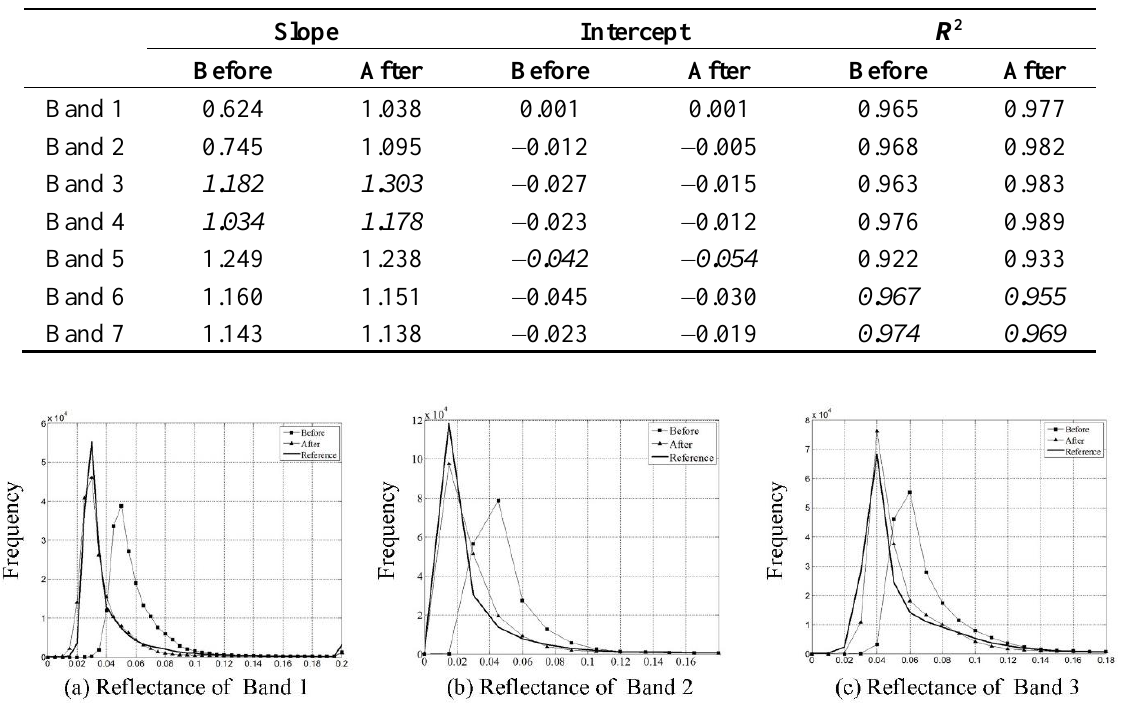
Figure 6. The reference image of the study area shown as a color composite with Bands 4 as red, Band 3 as green, and Band 2 as blue. The image was acquired on 29 July 2014. Table 2. Coefficients of linear regression analyses of Bands 1–7 before and after the cloud removal in comparison with the reference image (Five exceptional cases are italicized